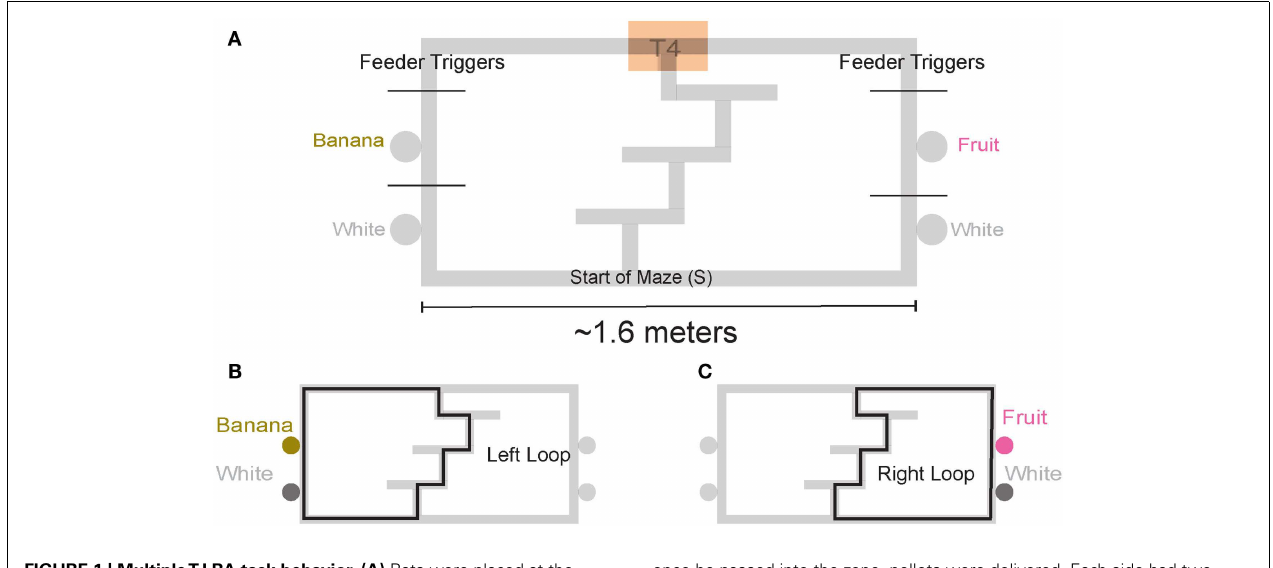
FIGURE 1 | MultipleT-LRA task behavior. (A) Rats were placed at the start of the maze (S). Reward was delivered as animals crossed the reward-trigger lines. Reward trigger zones were spatially defined and did not vary from day to day. On any given the day, if the rat chose correctly,